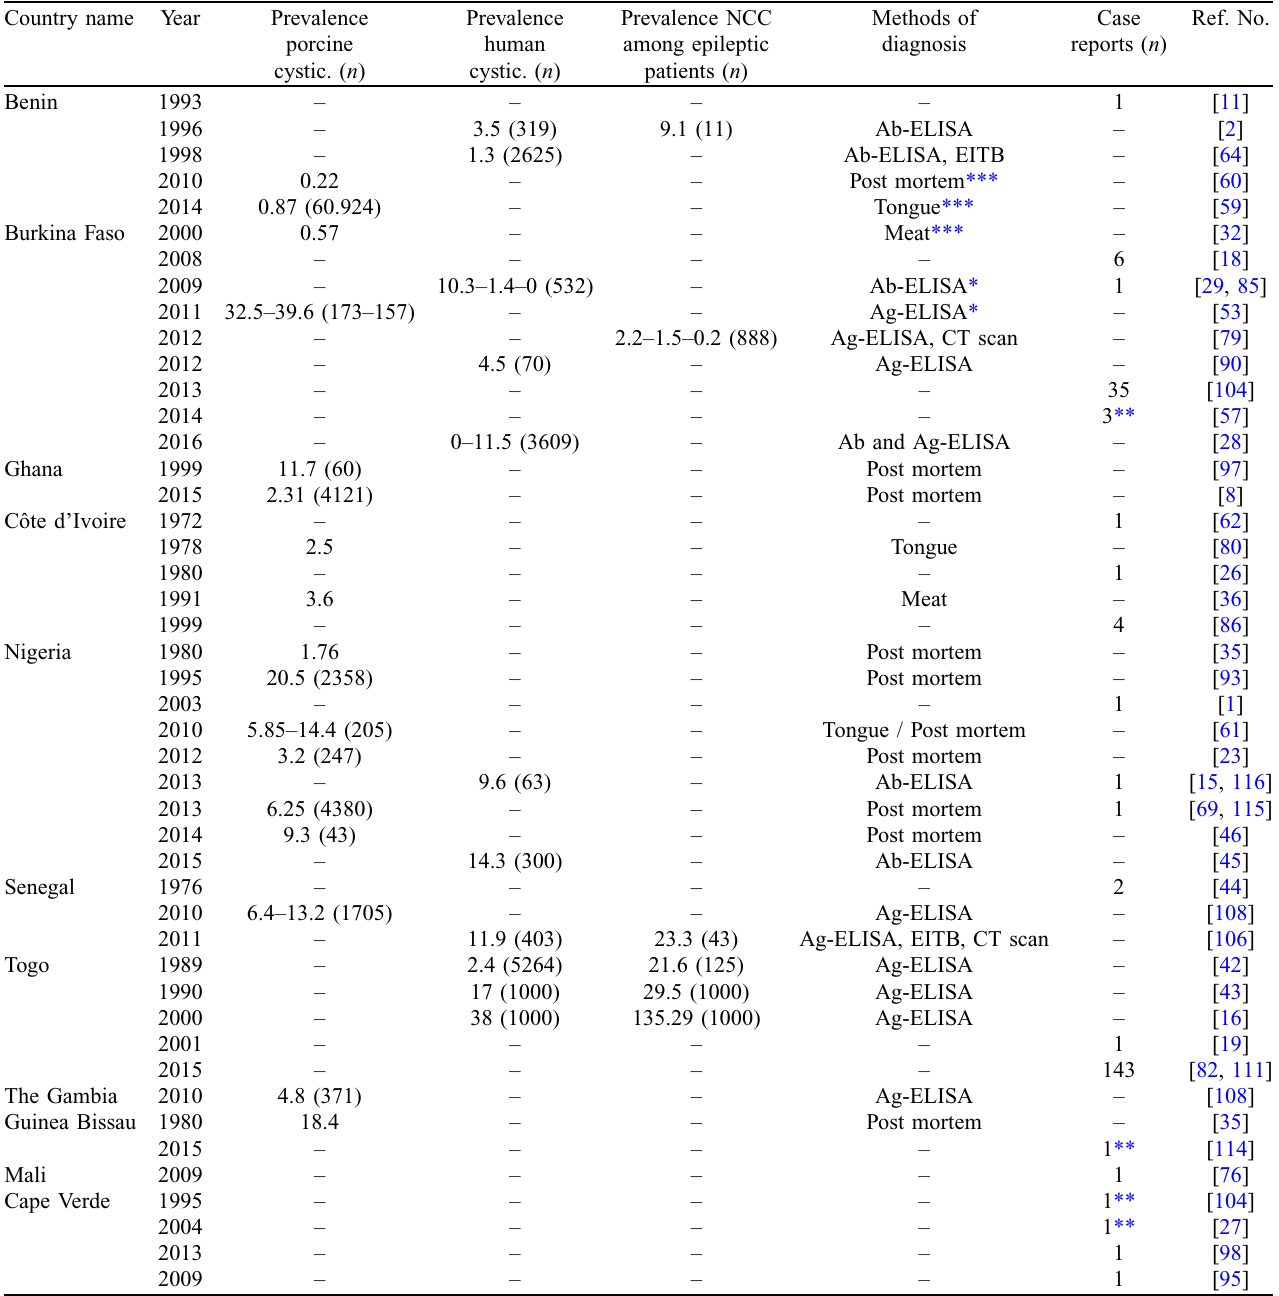
* Ag-ELISA: Monoclonal antigen-detection enzyme-linked immunosorbent assay on serum; Ab-ELISA: Monoclonal antibody-detection enzyme-linked immunosorbent assay on serum; ** Imported in Europe; *** Tongue or meat or post mortem inspection; ( n ) Number of subjects or animals